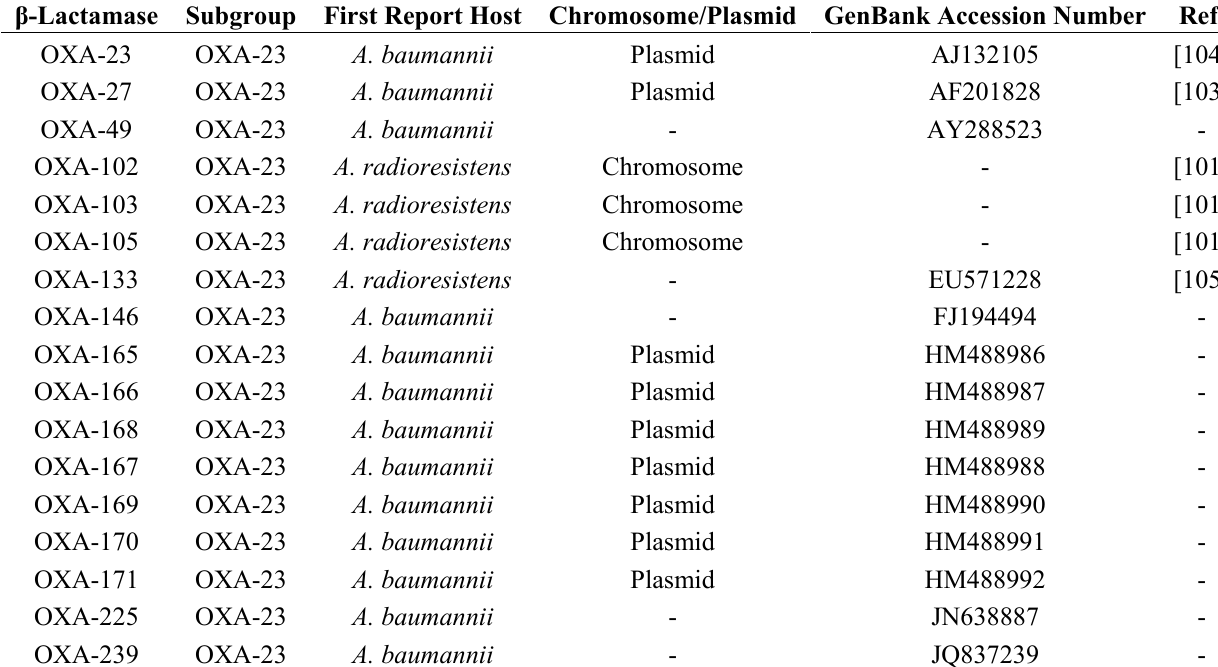
Table 10. OXA-23 like